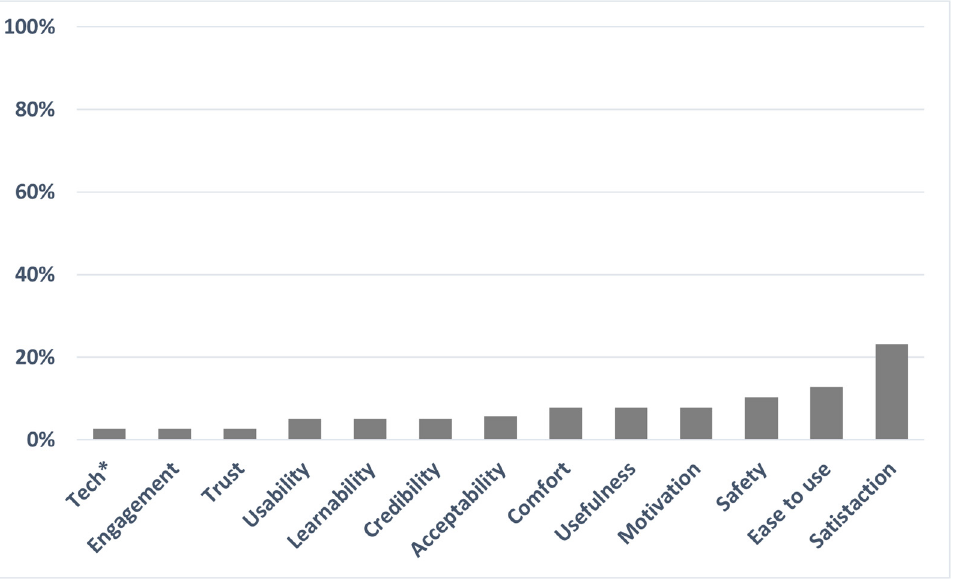
Figure 2. The user acceptance constructs used by the authors included in the review. The percentages indicate how many times each construct was administered. Note. * The tech construct refers to the technical aspects of the AT (i.e., weight, dimension).